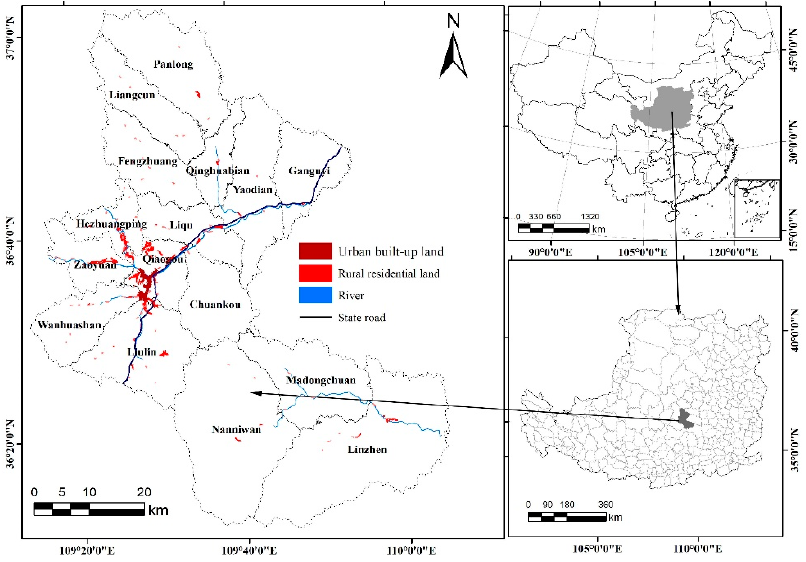
Figure 2. Location of the Baota District. The district contains 5 streets, 12 towns, and 623 administrative villages, with a population of 478,782. During the process of urbanization and industrialization, the conflicts between population growth and land supply in Baota have intensified. From 1990 to 2015, the average annual growth rate of the rural population in Baota was 0.7%, while the average annual growth rate of rural residential land was 3.1%. The growth rate of rural residential land was much faster than the population growth rate, which restricted sustainable regional development. Hence, the Baota District is a good sample for studying the rural residential land expansion of ecologically fragile